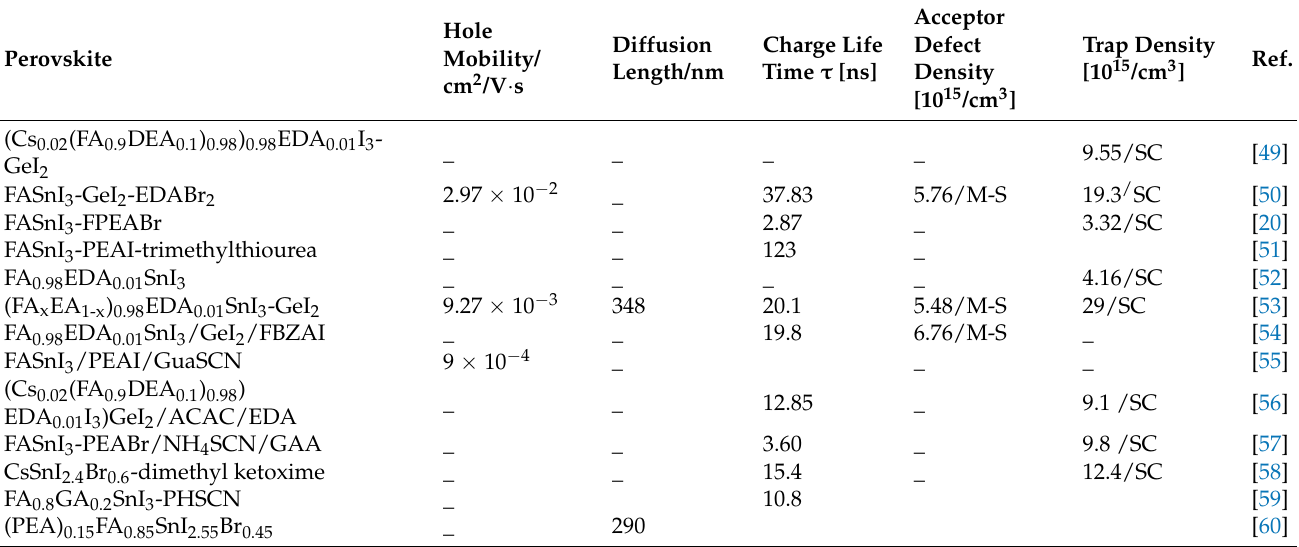
Table 4. The summary of electronic parameters of Sn-PVK layers. Hole cm 2 /V · s